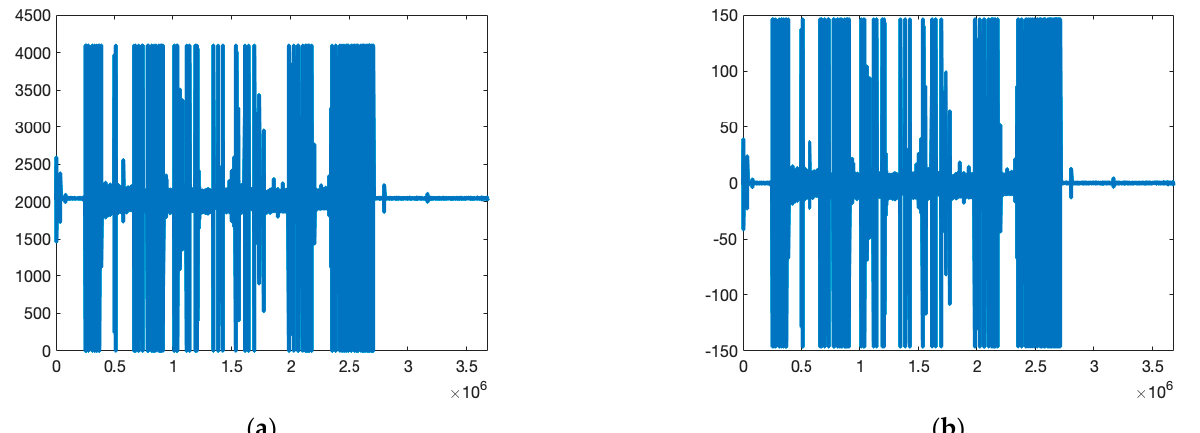
Figure 2. Normalization of BCG signals. ( a ) An example of raw BCG signal from the dataset. ( b ) Normalized BCG signal.